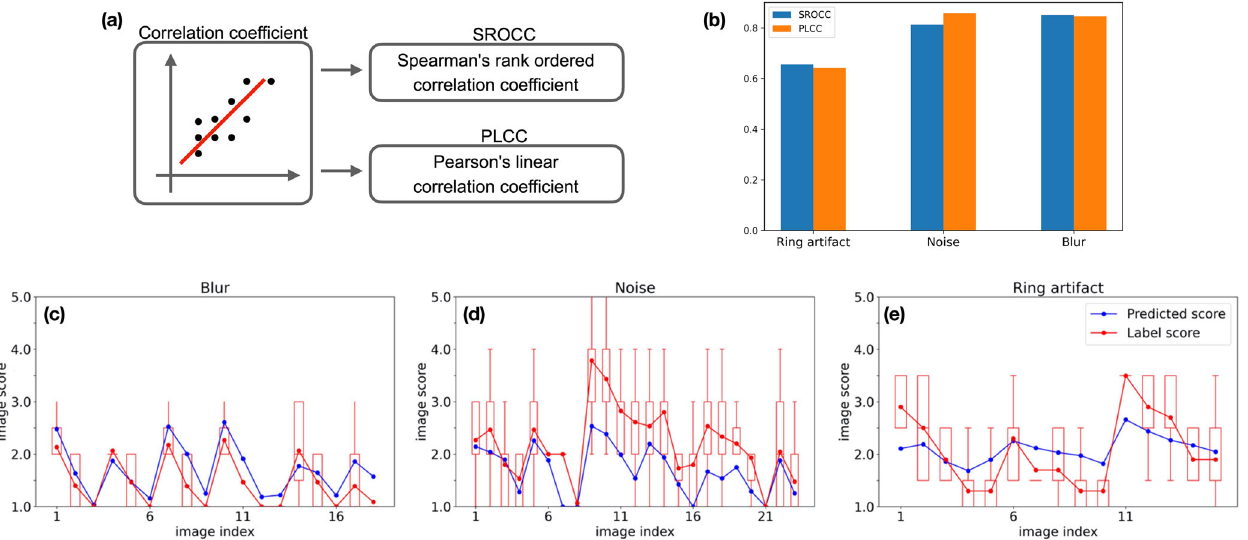
Fig. 3 Evaluation results of label projection module. It shows the data augmentation performance for three types of distortions. a , b Demonstrate the correlation between predicted scores and human annotated scores in three types of distorted images. c – e Illustrate the quantitative value of the predicted scores and human labels of images with blur, noise, and ring artifact. The red boxes represent the con fi dent human